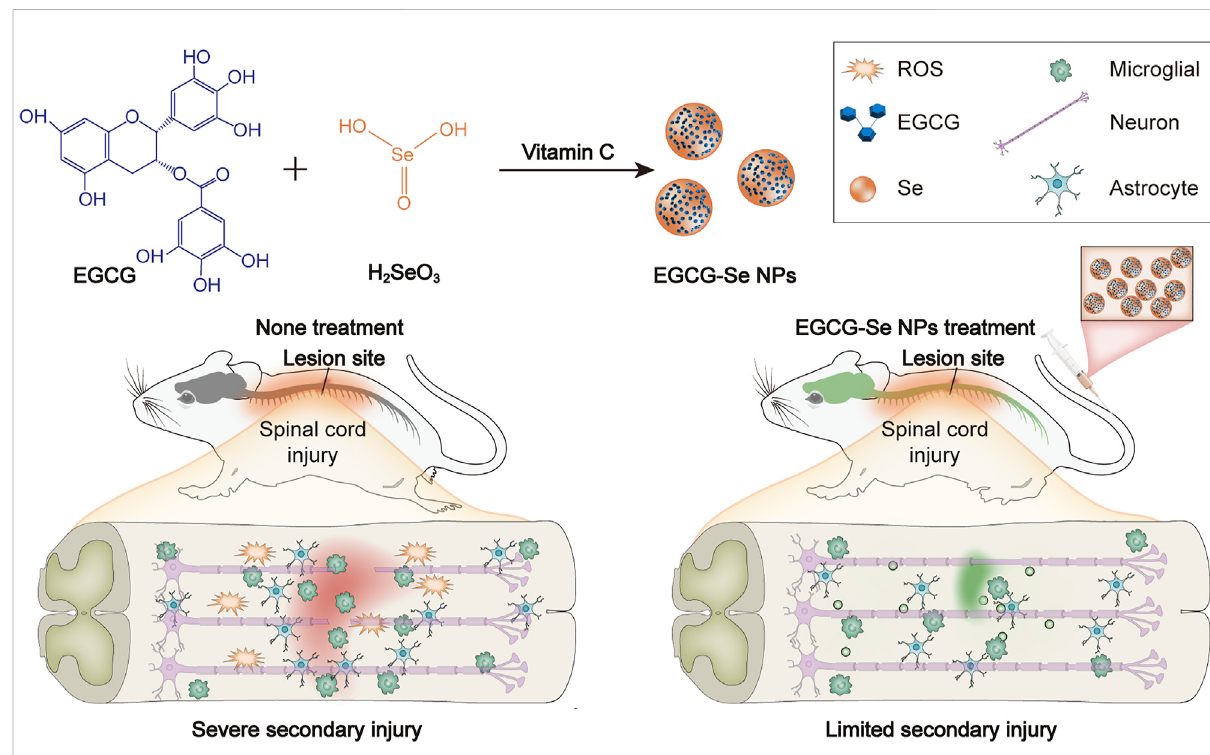
FIGURE 1 Preparation of epigallocatechin-3-gallate selenium nanoparticles (EGCG-Se NP) for treatment of spinal cord injury by scavenging reactive oxygen species (ROS) and suppressing in fl ammation.